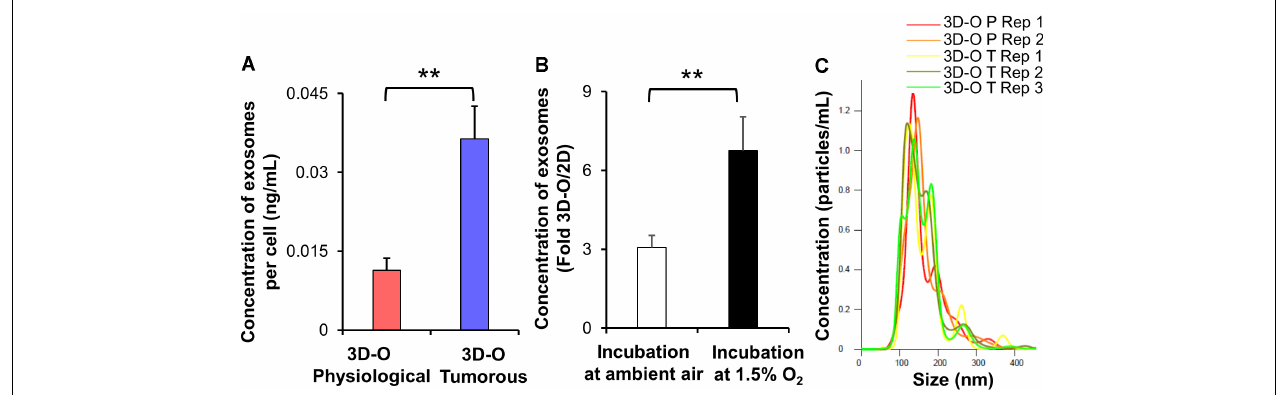
FIGURE 5 | Low-oxygen within 3D-O matrices affects extracellular vesicle secretion. (A) The concentration of extracellular vesicles generated per MDA-MB-231 cell (ng/mL) grown within 3D-O physiological and 3D-O tumorous matrices for 4 days. (B) Fold change concentration of extracellular vesicles generated per cell (ng/mL) grown for 4 days either in 3D-O culture or matching traditional 2D culture and incubated either in ambient air or 1.5% O 2 . (C) Representative plot for extracellular vesicle size (nm) versus concentration (particles/ml) from replicates of 3D-O physiological (3D-O P) and 3D-O tumorous (3D-O T) matrices. ** p < 0.001, data were analyzed using unpaired two-tailed Student’s T